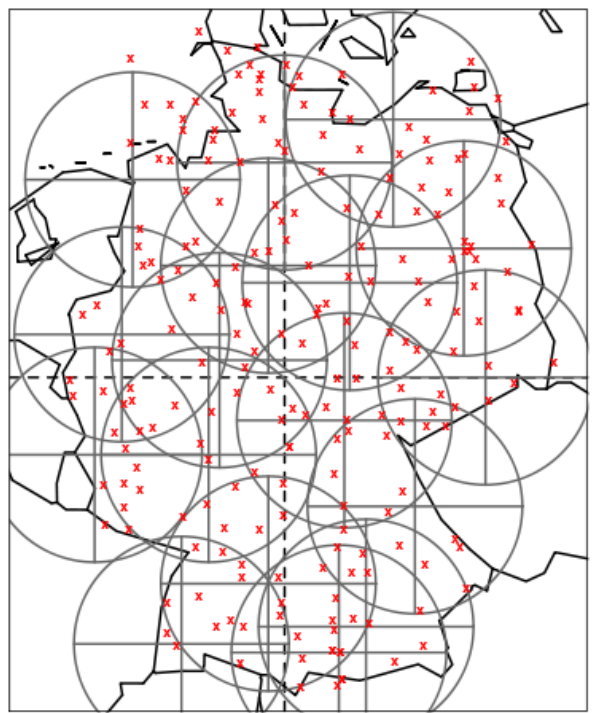
Figure 1. Data used in the analysis. Map of Germany with the syn- optic stations (red crosses) and the radar locations and approximate range (gray circles). Dashed black lines indicate the division of the domain into